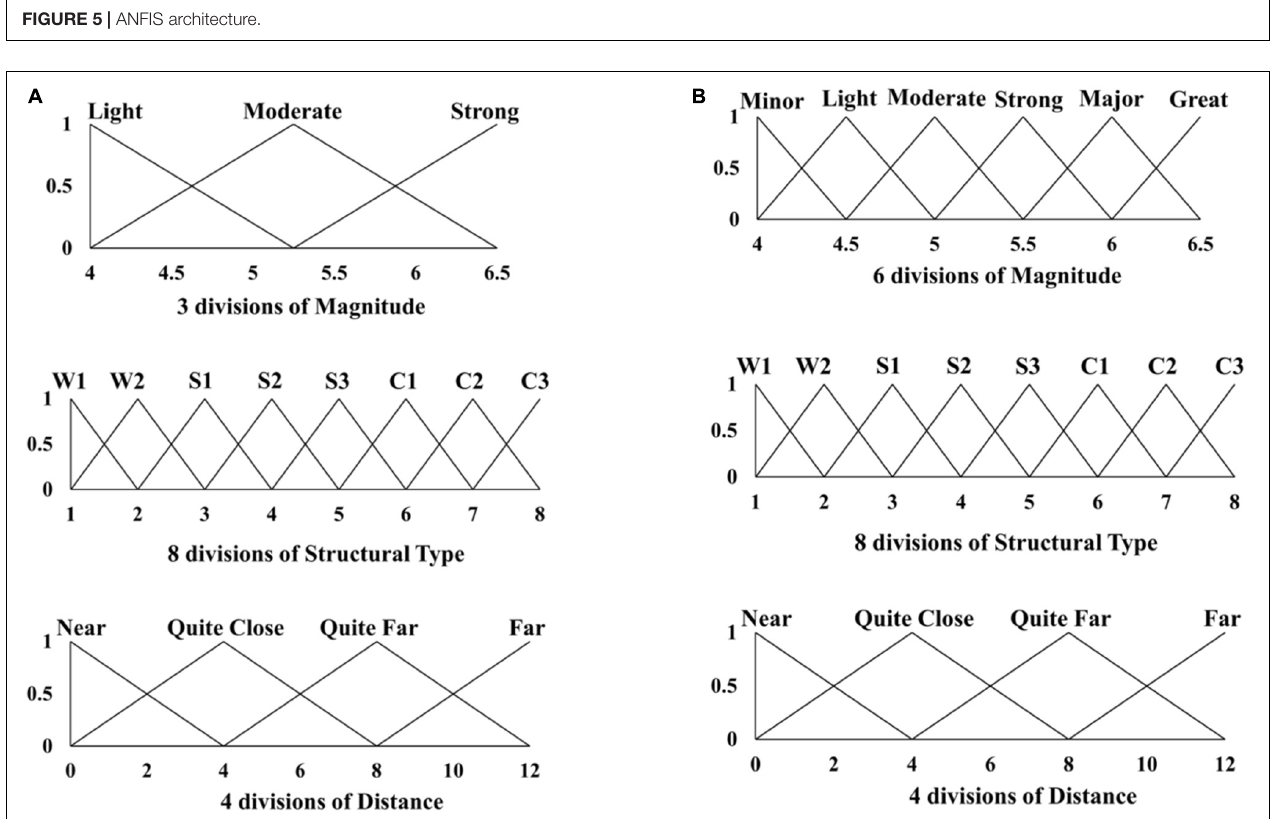
FIGURE 6 | Triangular membership function (Trimf model) with two configurations of division. (A) 3-8-4 model (Trimf membership function); (B) 6-8-4 model (Trimf membership